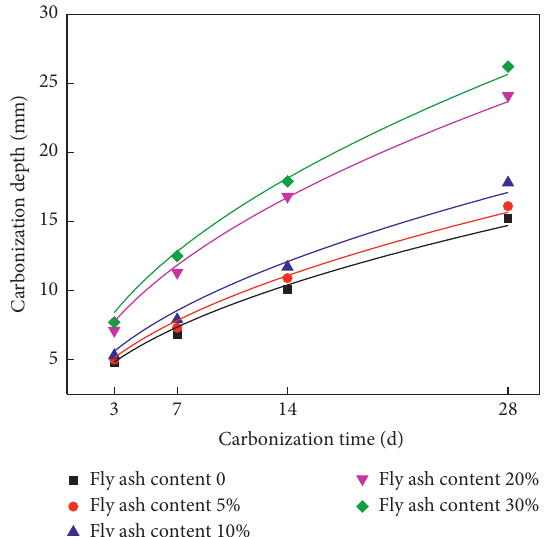
Figure 8: Carbonation depth fitting curve of hybrid fiber concrete with different powder and fly ash